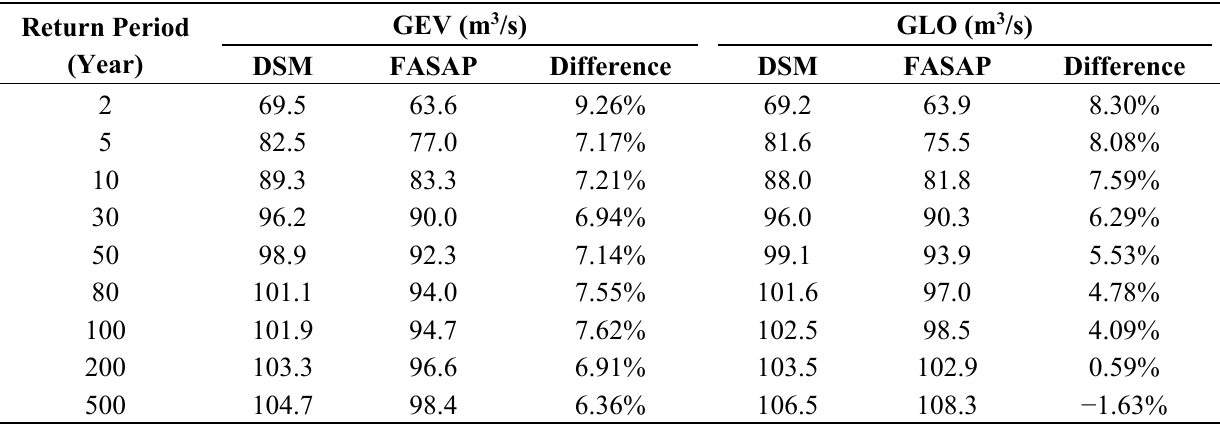
Table 9. The estimated flood quantiles and the differences for the applied methods. FASAP: flood frequency analysis for the simulated annual peak flows ; DSM: Design storm